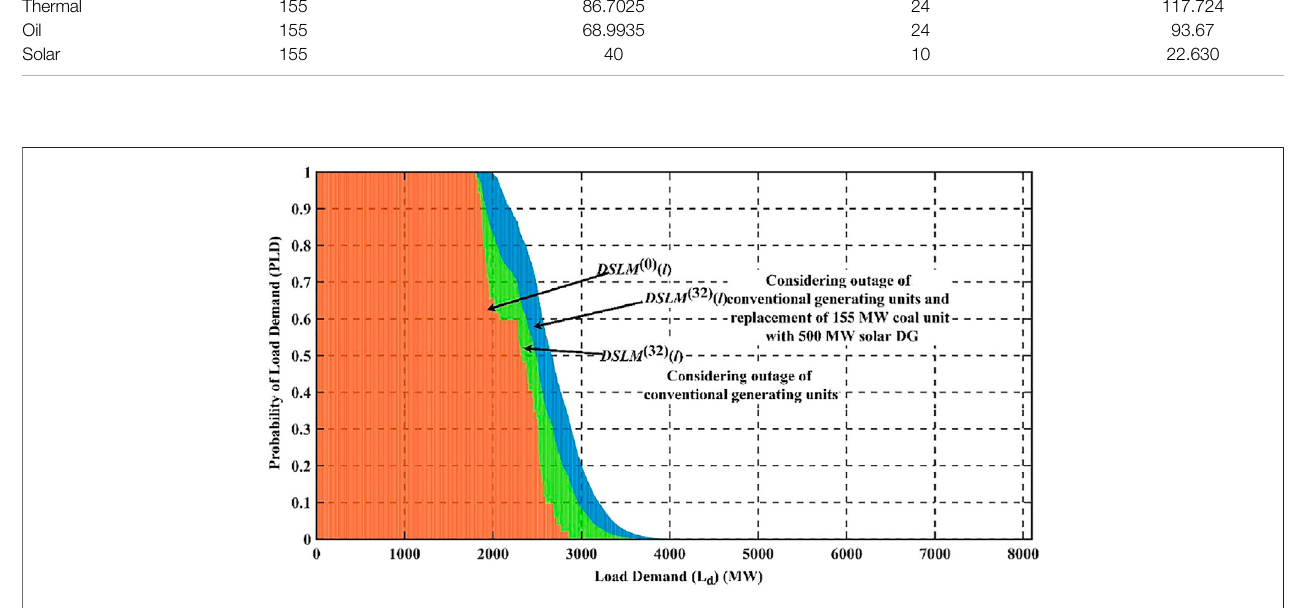
FIGURE 8 | DSLM for IEEE-RTS and modi fi ed RTS.